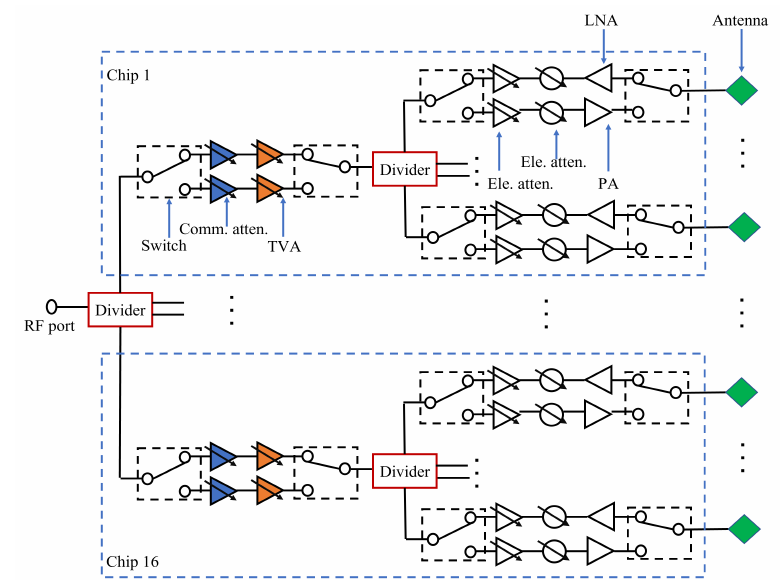
Figure 2. Block diagram of the 8 × 8 AiP.